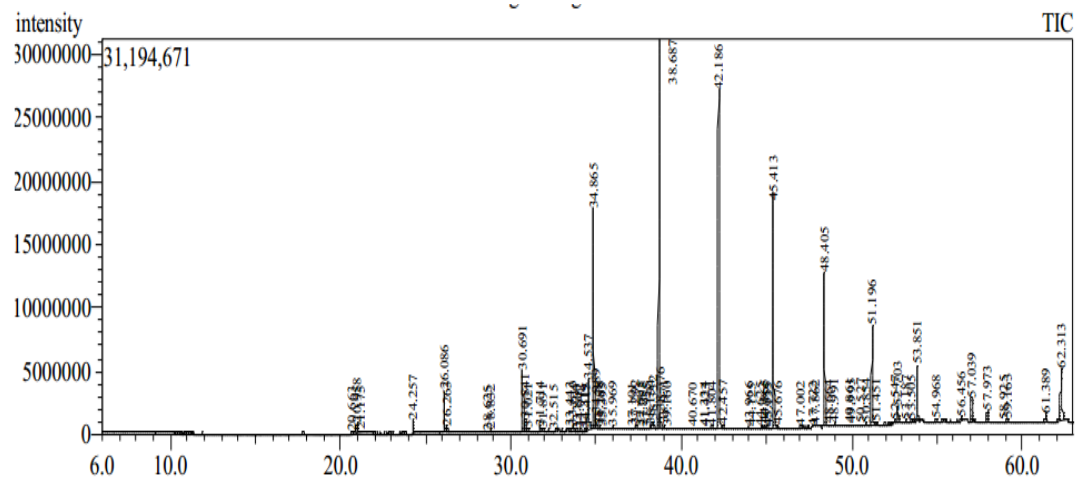
Figure 8. GC/MS for chloroform fraction. Table 3. Compounds identified in chloroform fraction GC/MS .